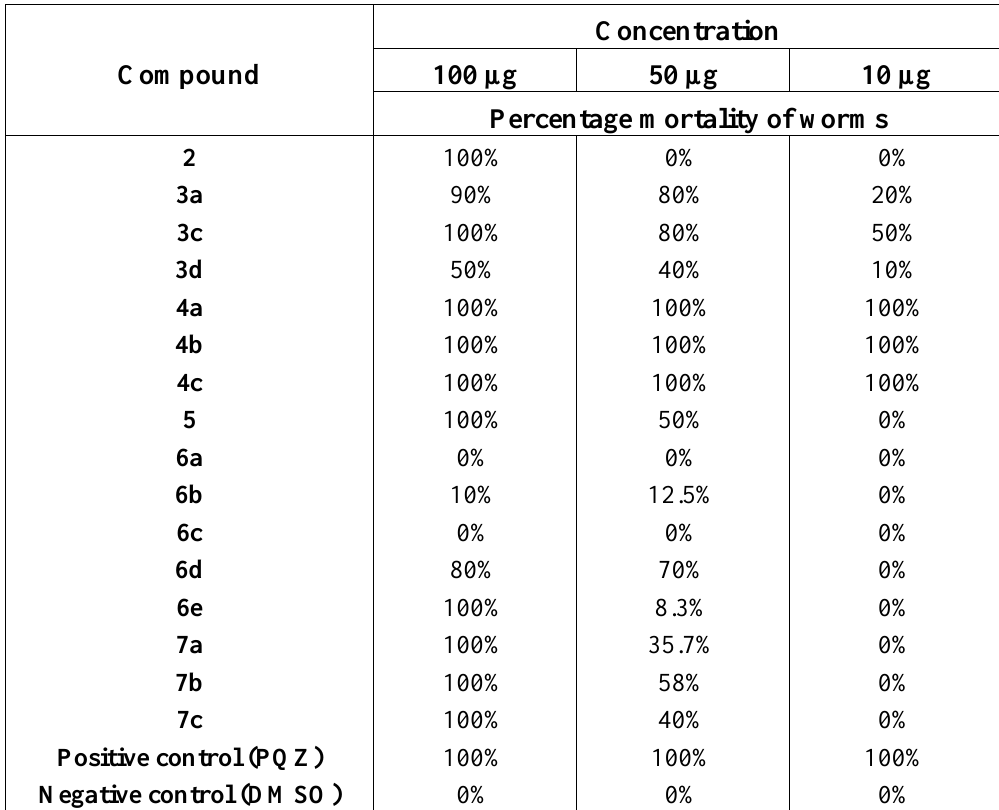
Table 1: Percentage Schistosoma mansoni worm mortality under different concentrations of praziquantel (PZQ) and the newly synthesized